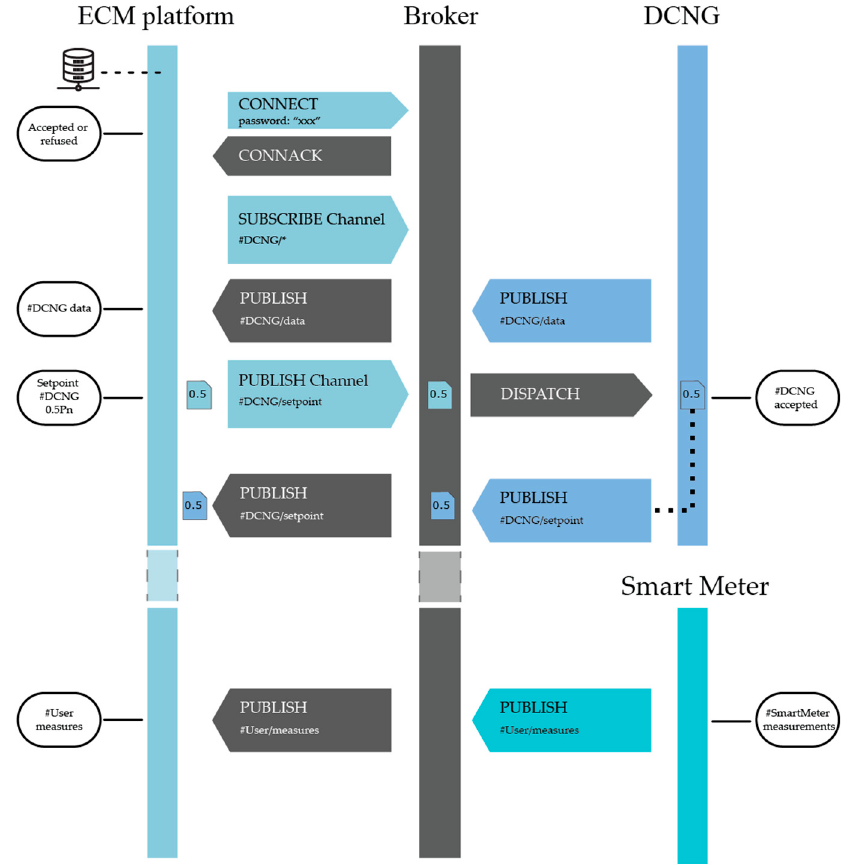
Figure 8. Data flow control summary of the communication protocol among the DCNG, SM and aggregator.